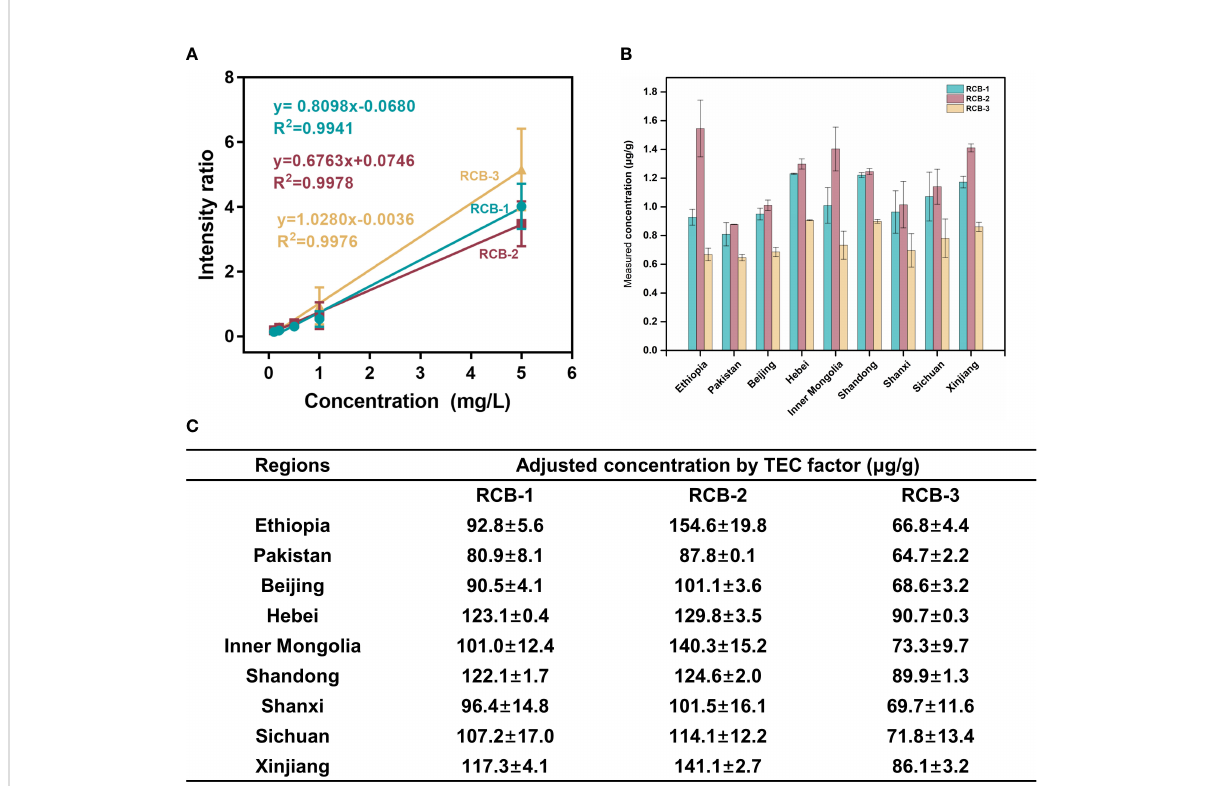
FIGURE 5 Quantitation of RCB-1,-2 and -3 in castor bean tissues from nine geographical sources by MALDI-MSI. (A) Calibration curves of RCB-1, -2, and -3, the error bars in the graph represented the standard deviation of three microspots for each calibration solution; (B) The measured concentrations, and (C) the adjusted concentrations by TEC factor of RCB-1, -2, and -3 in castor bean tissues from nine geographical